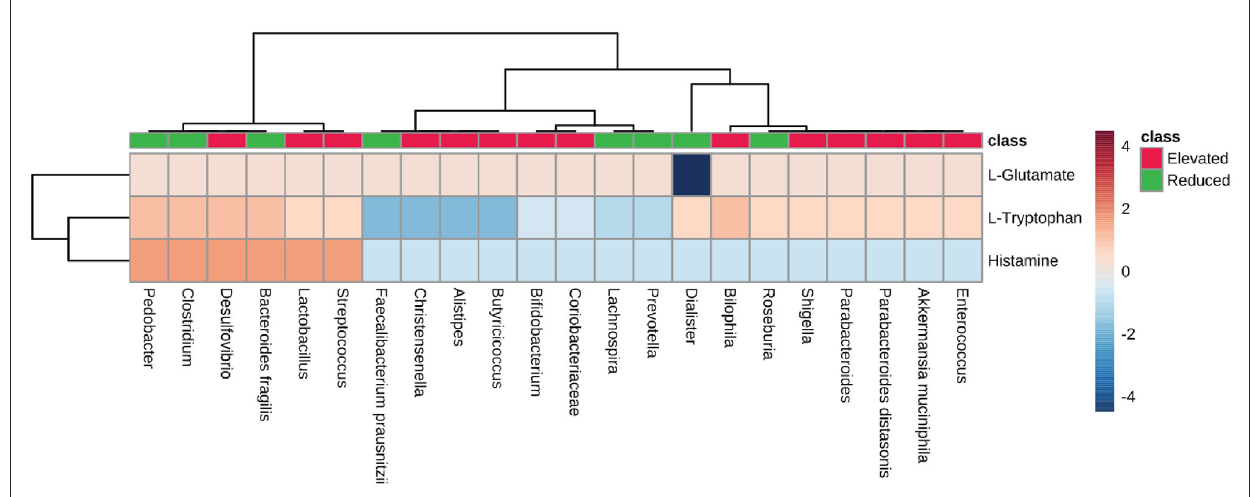
FIGURE7 Neurotransmitter precursor synthesis pathway analysis. Heatmap showing pathway scores for producing neurotransmitter precursors like L-glutamate, L-Tryptophan, and histamine in the gut by microbes found in elevated and reduced conditions in AD, PD, MS, and